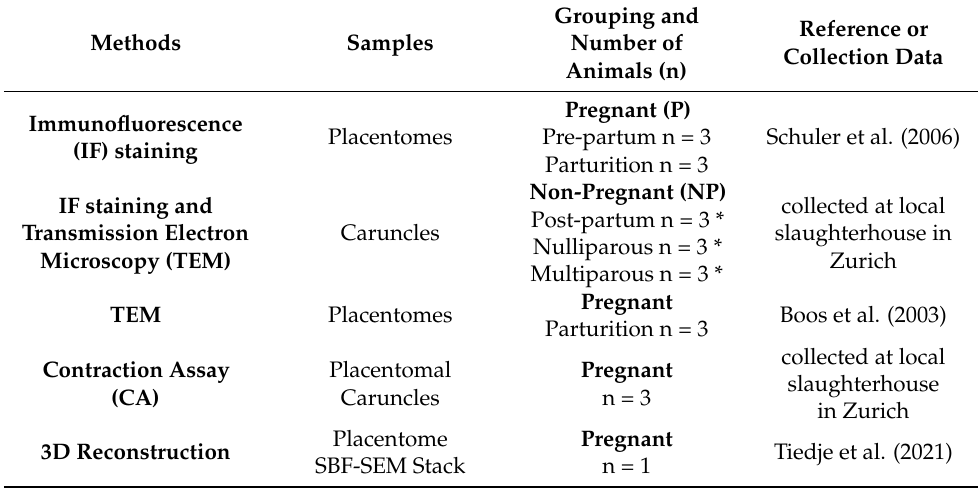
Table 1. Information on the tissue samples used in this study. * For each method, IF and TEM: n =